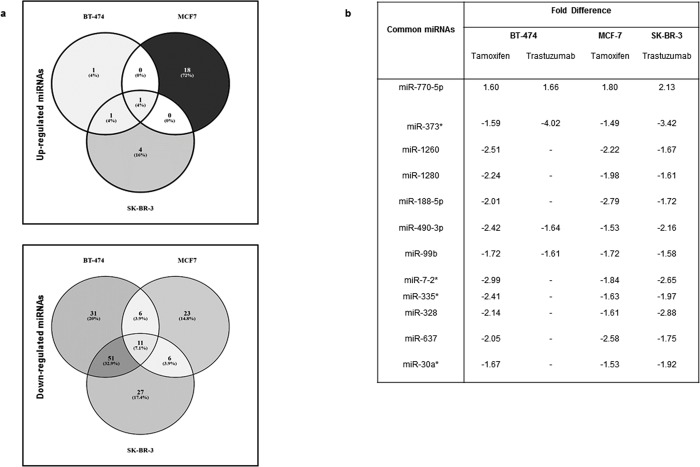
Trastuzumab and Tamoxifen responsive miRNAs were identified by qRT-PCR Array.(a) HER2+ and ER+ BT-474 cells were treated with both tamoxifen and trastuzumab while ER+ MCF-7 cells and HER2+ SK-BR-3 cells were only tretated with tamoxifen and trastuzumab respectively. There was only one common responsive miRNA among upregulated miRNAs; 11 miRNAs were commonly downregulated in all cell lines. The common responsive miRNAs are listed in b.